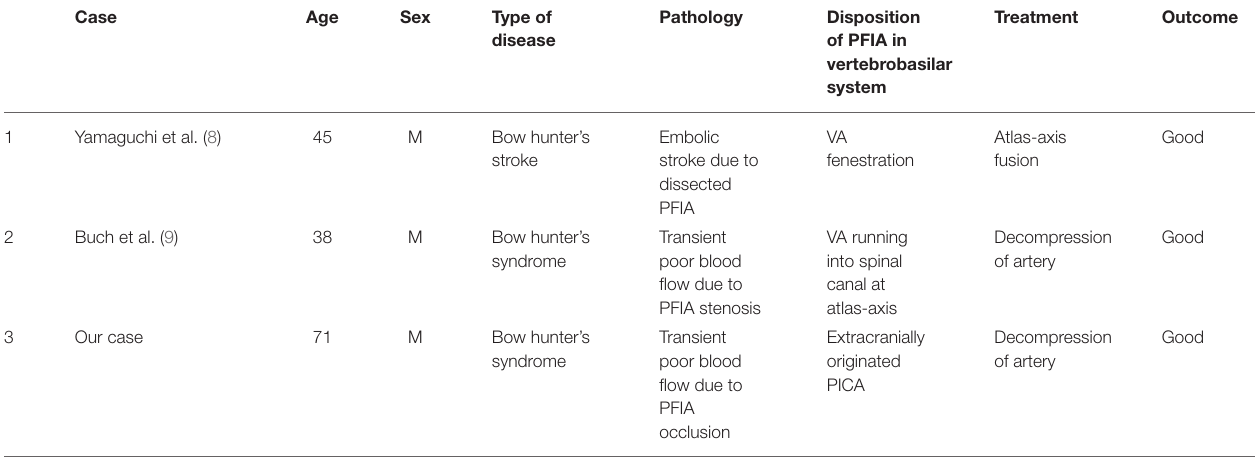
TABLE 1 | PFIA-associated Bow hunter’s